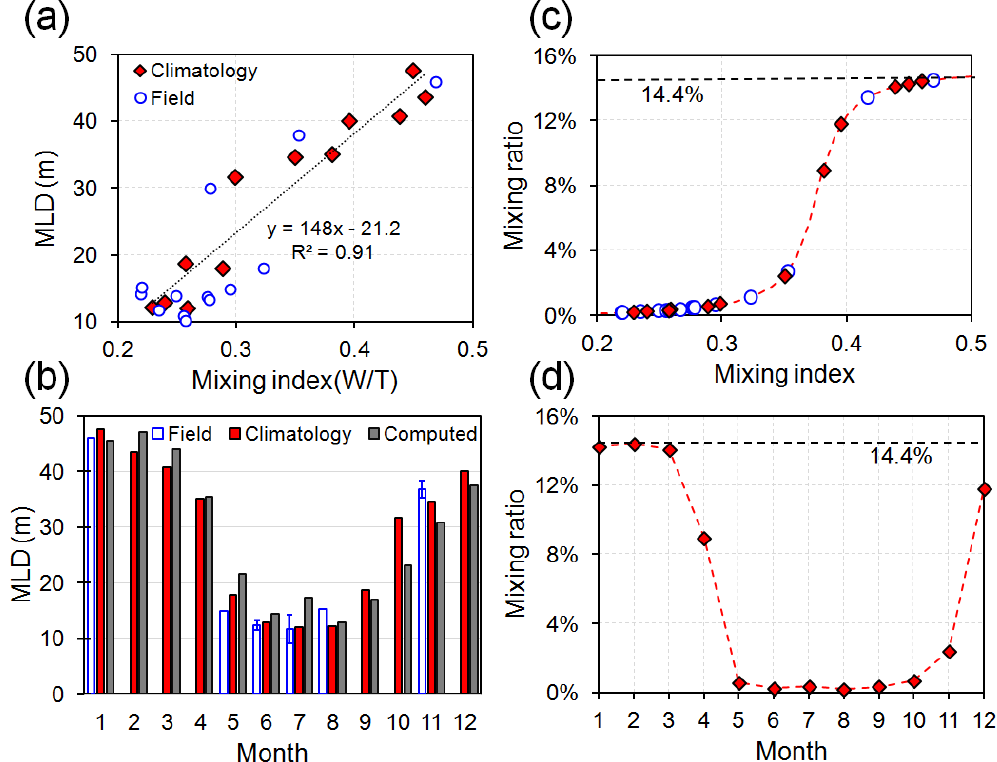
Figure 6. (a) Relationship between averaged MLD obtained from monthly climatology and field observations and mixing index ( W/T ). (b) Comparison of the computed MLD with those from climatology and field. (c) Arctangent relationship between the mixing index and contribution ratio. Blue dot: field surveys; red diamond: climatology monthly averages. (d) Monthly variability in the contribution ratio of vertical mixing in the